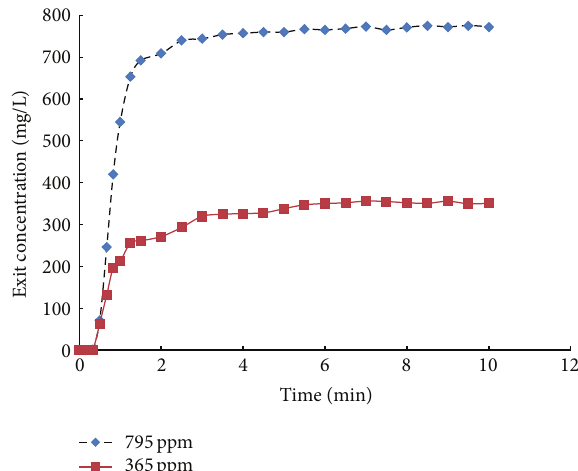
Figure 9: Effect of initial CO 2 concentration on adsorption. Reac- tion conditions: CO 2 /N 2 flow rate of 0.3 L/min, 1.5 g ash, 20% RH, and 22 ∘ C.